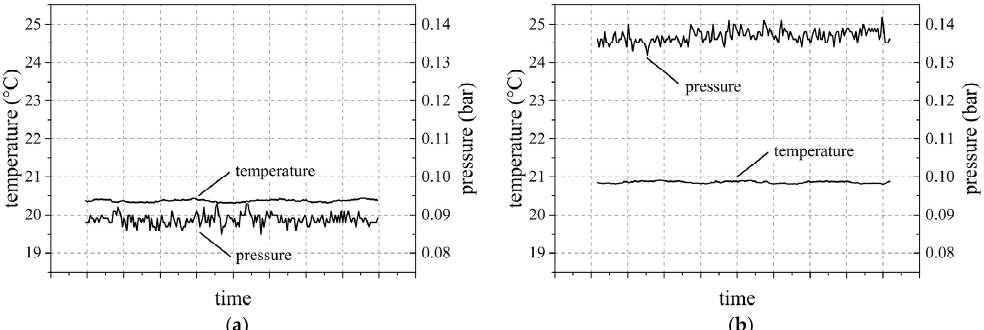
Figure 3. Experiment with a temperature of 420 °C and a duration of 72 h: ( a ) temperature and pressure before the experiment; and ( b ) temperature and pressure after the experiment.